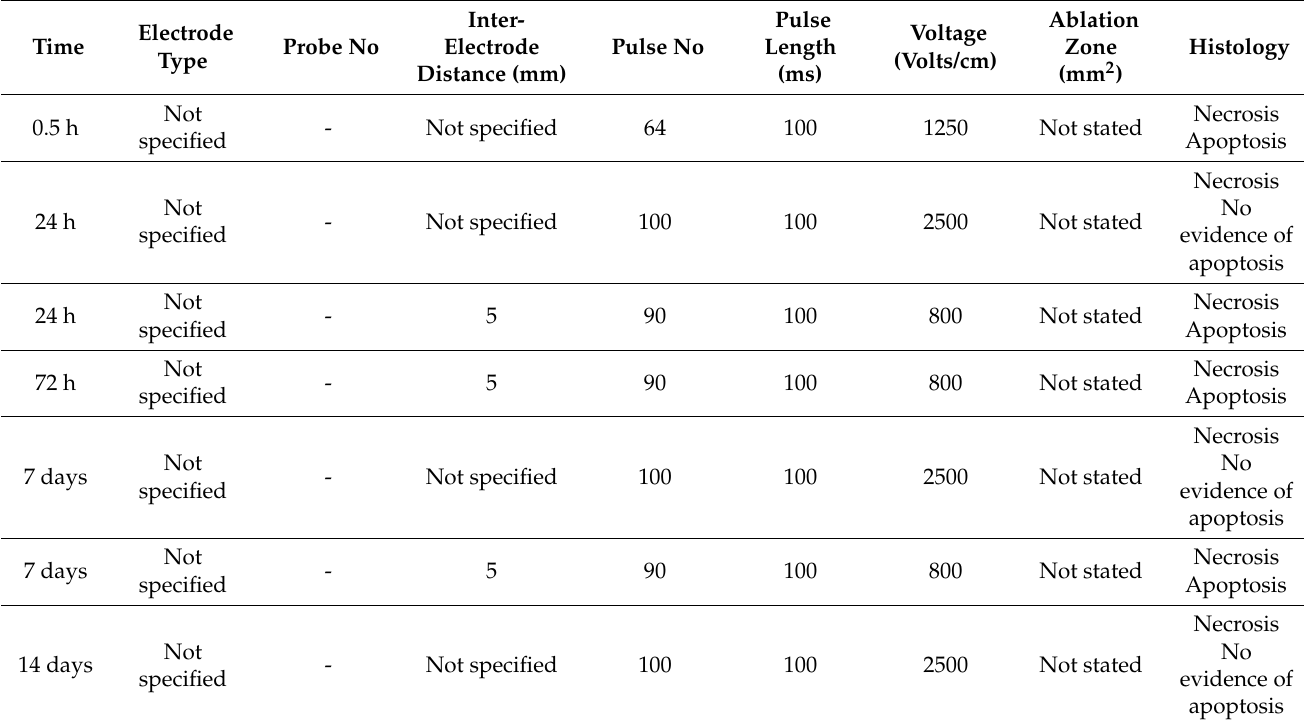
Table 4. Histological changes at specific IRE settings and time course following IRE to murine pancreatic cancer models